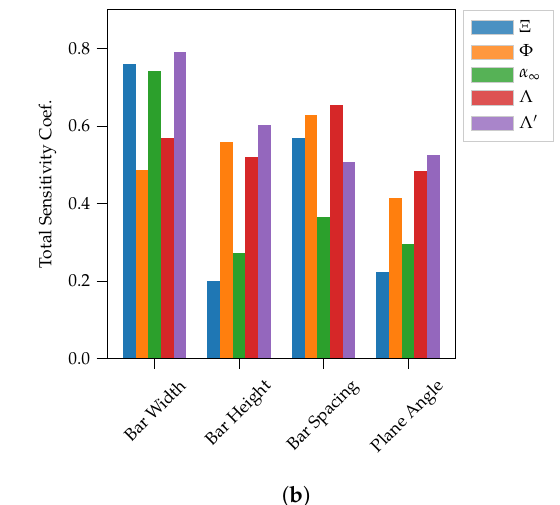
Figure 5. First order and total sensitivity coefficients of the microscale geometry parameters of the porous material with respect to the JCA model parameters. Results reported after 1 · 10 6 Monte Carlo runs (Quasi Monte Carlo with Sobol sequence). The Greek letters denote the JCA model parameters, i.e., Ξ : flow resistivity, Φ : porosity, α ∞ : tortuosity, Λ , Λ (cid:48) : viscous and thermal characteristic length, respectively. ( a ) First-order sensitivity coefficients. ( b ) Total sensitivity